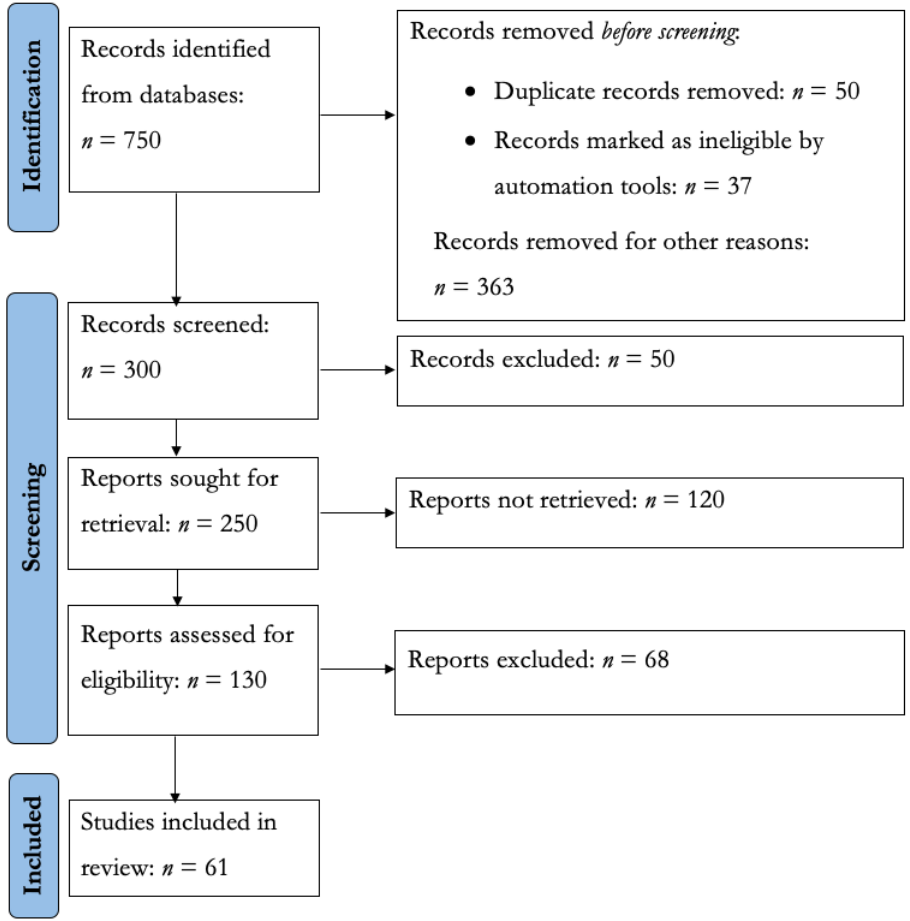
Figure 2. PRISMA flowchart of primary studies